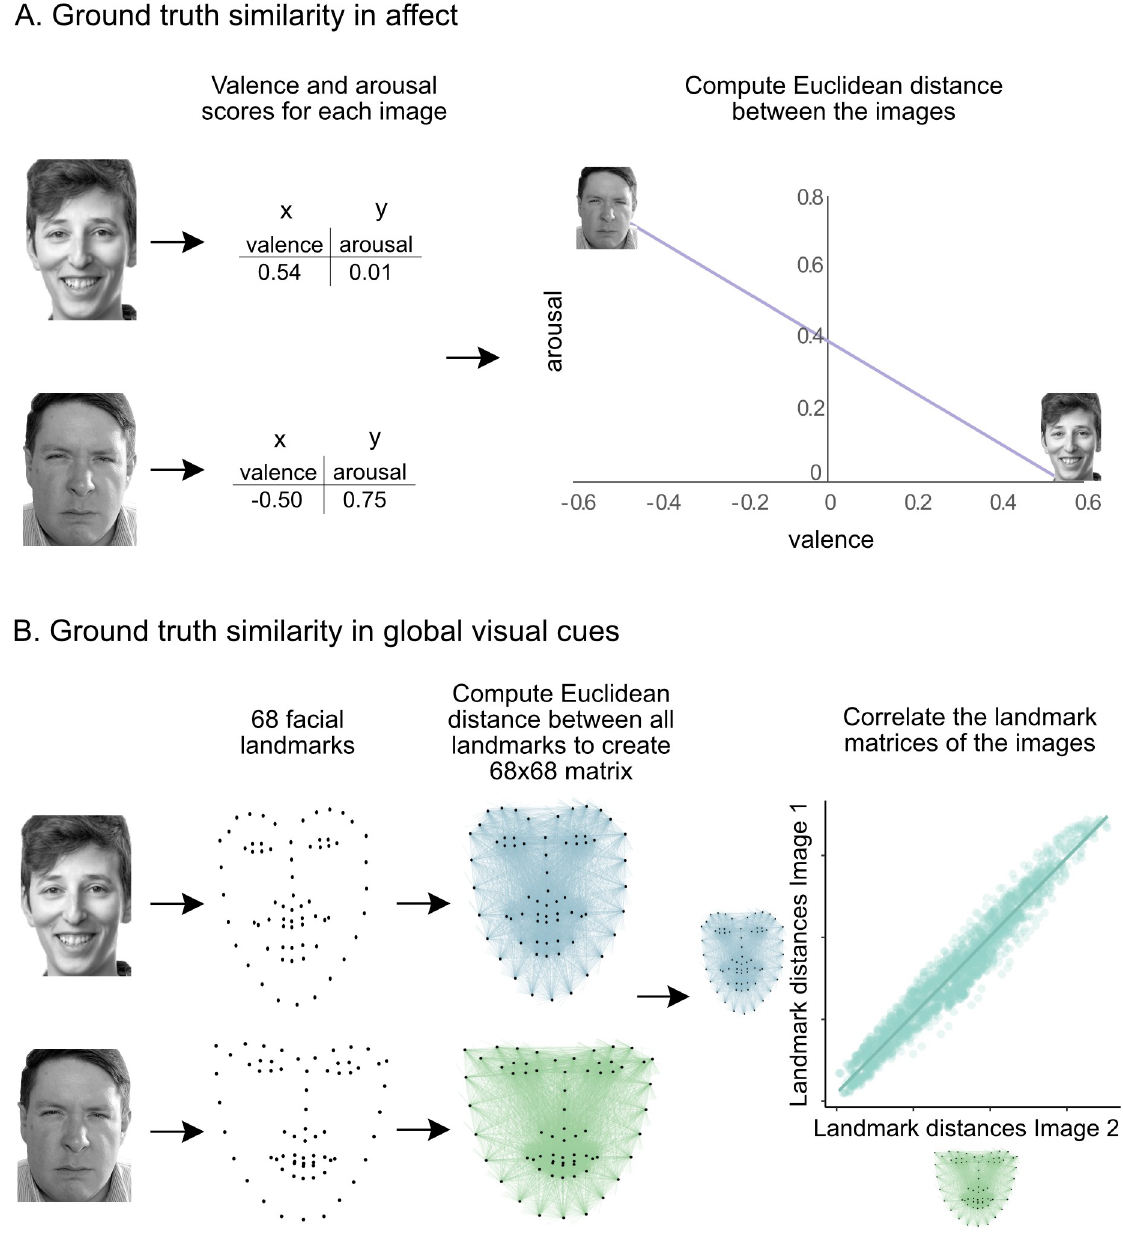
Fig 2. Ground truth calculations. A) The ground truth affective similarity is based on valence and arousal ratings. These ratings served as x- y coordinates for each face. The affective similarity score was calculated as the Euclidean distance between these values. B) The ground truth visual similarity is based on the Euclidean distances between all 68 facial landmarks. These landmarks were obtained from automated software (ResNext) for each face. Distances between each landmark were represented in a 68x68 matrix for each image. The global visual similarity score was calculated as the correlation between these two vectorized